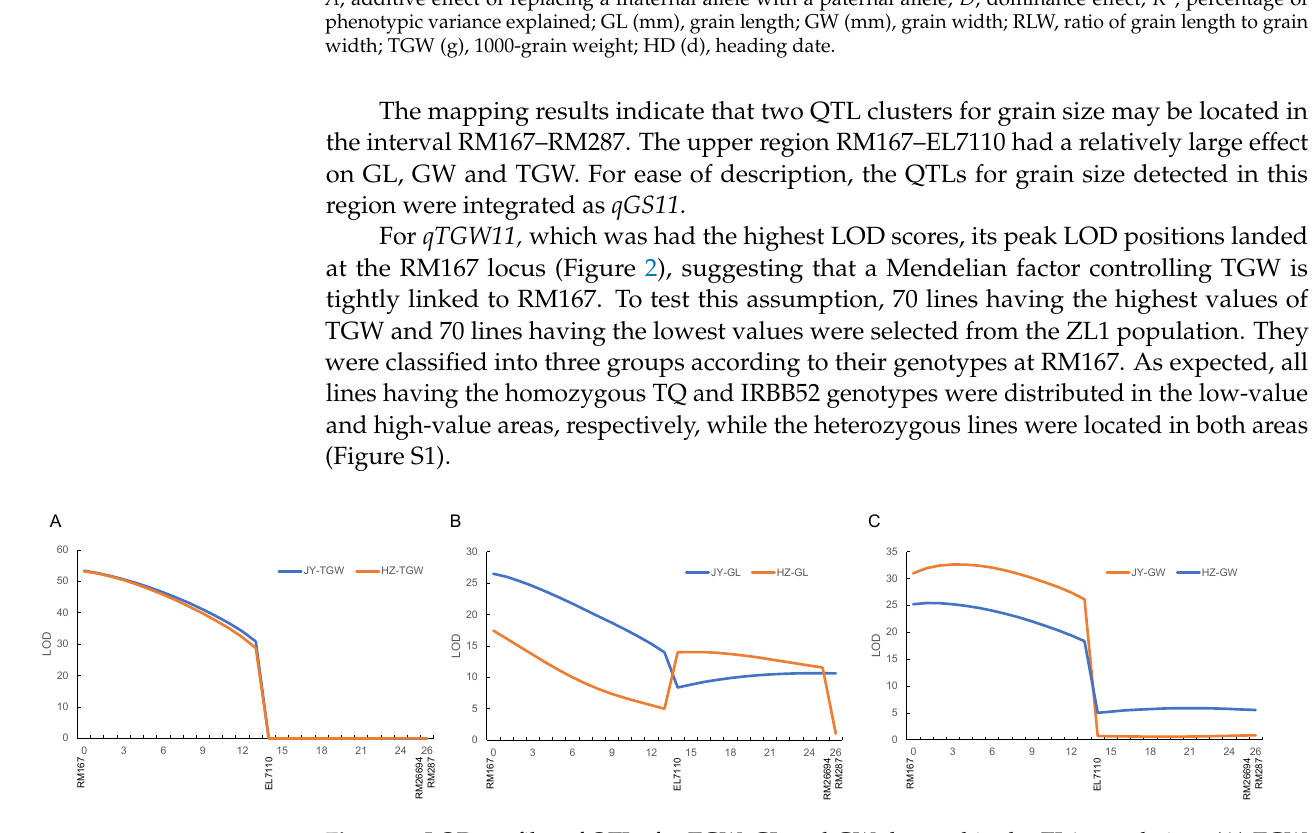
Table 3. QTLs detected in the ZL1 population.